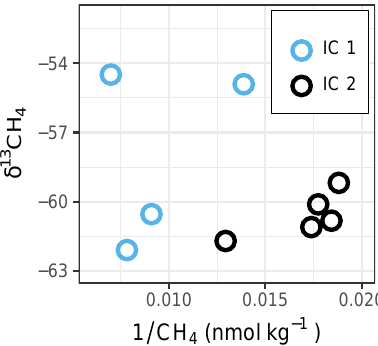
Figure 6. δ 13 CH 4 vs. reciprocal of CH 4 concentration (Keeling- type plot) of ice cores. Within each ice core, a shift to more positive δ 13 CH 4 values in combination with a decrease in CH 4 concentra- tion indicates microbial oxidation. Comparing IC2 to IC1, the shift toward higher concentrations and more positive δ 13 CH 4 (see also Fig. 2) in IC1 might indicate CH 4 production from a substrate with heavier isotope signature, compared to the values in